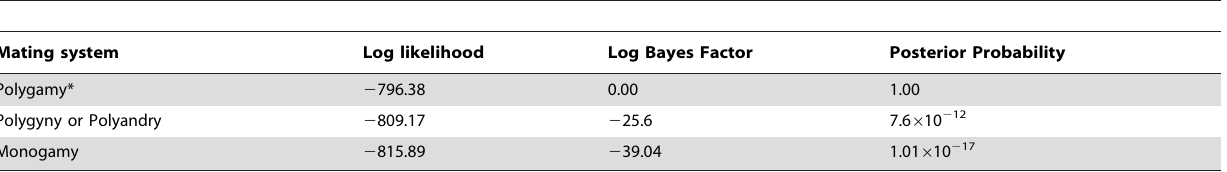
Table 3. Maximum log-likelihood values for mating system models suggested for T. terrestris , with associated log Bayes factor and posterior probabilities.